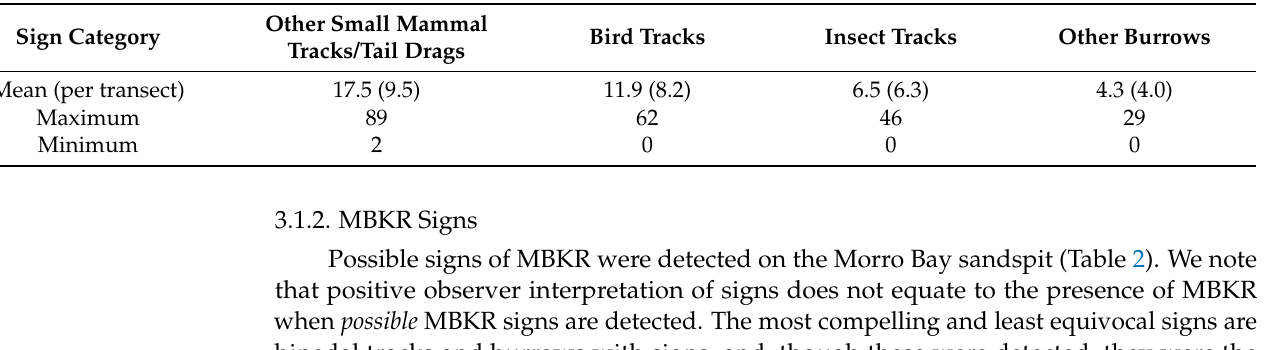
Table 1. Summary of overall signs found at the Morro Bay sandspit in San Luis Obispo County, CA., during visual surveys for signs of Morro Bay kangaroo rats. Mean per transect, standard deviation (SD), maximum, and minimum were calculated across all transects pooled.